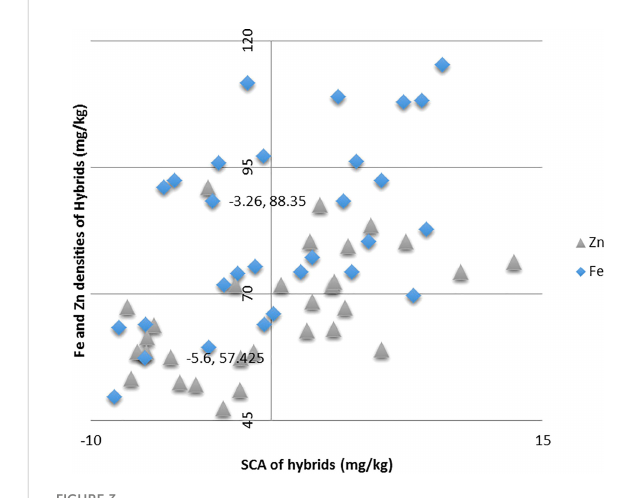
FIGURE 3 Relationship between grain Fe and Zn densities of hybrids and their speci fi c combining ability (SCA) effects in line × tester across two